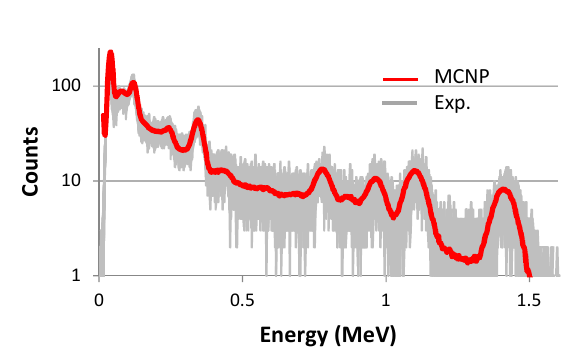
Fig.6. Comparison between 30 experimental and one simulated pulse height distributions from a Eu-152 source inside PEHD container (thick 8 cm) for 2s acquisition time.